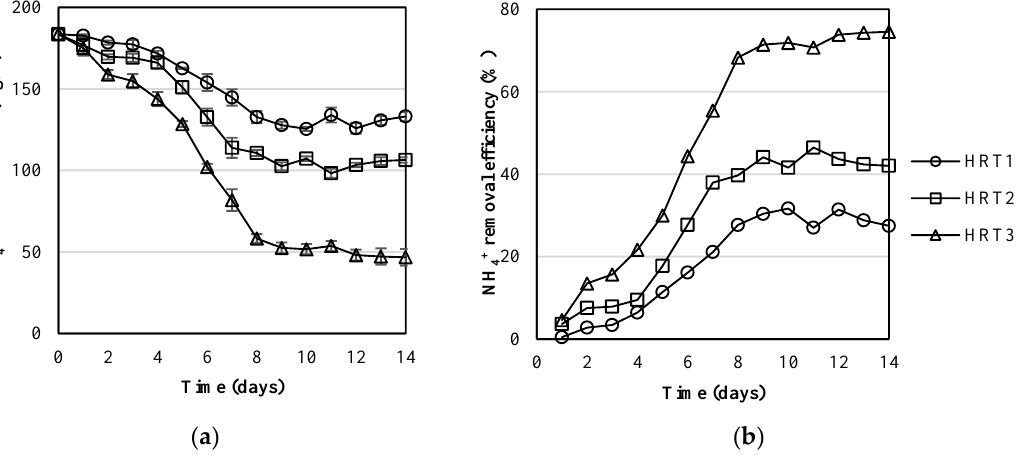
Figure 3. The change of ( a ) NH 4+ concentration and ( b ) NH 4+ removal efficiency in 2-fold diluted piggery wastewater over 14 days in Chlorella vulgaris -based MPBR at various hydraulic retention times (HRT1 = 1.25 days, HRT2 = 2.5 days, HRT 3 = 5 days).